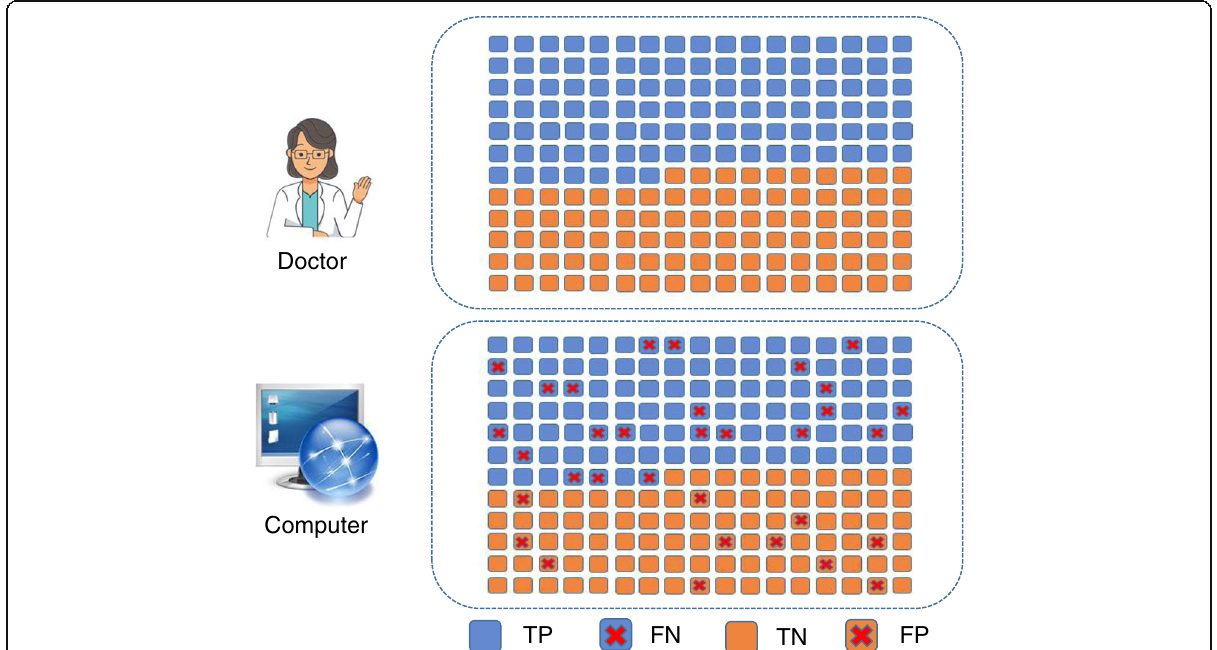
Fig. 9 The result of the multi-clinical patient tests. This shows the diagnostic results of the doctor and ZSAL, in which the blue square indicates a